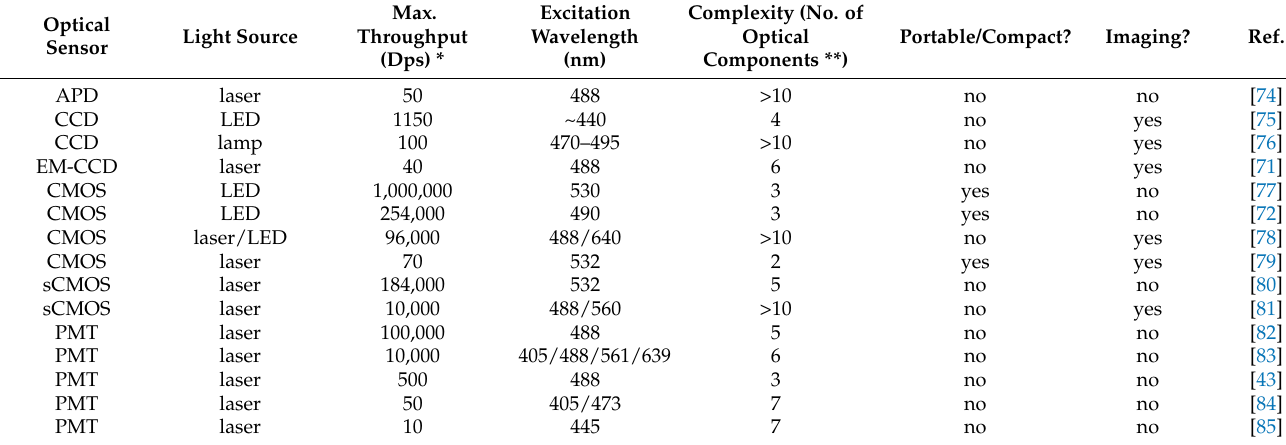
Table 2. Comparison of the complexity and performance of detection setups used in droplet microflow cytometry (DMFC)